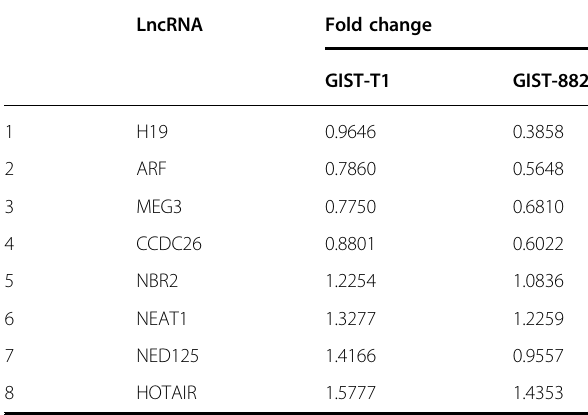
Table 1 Initial pro fi ling of long noncoding RNAs in response to Imatinib treatment in gastrointestinal stromal tumors